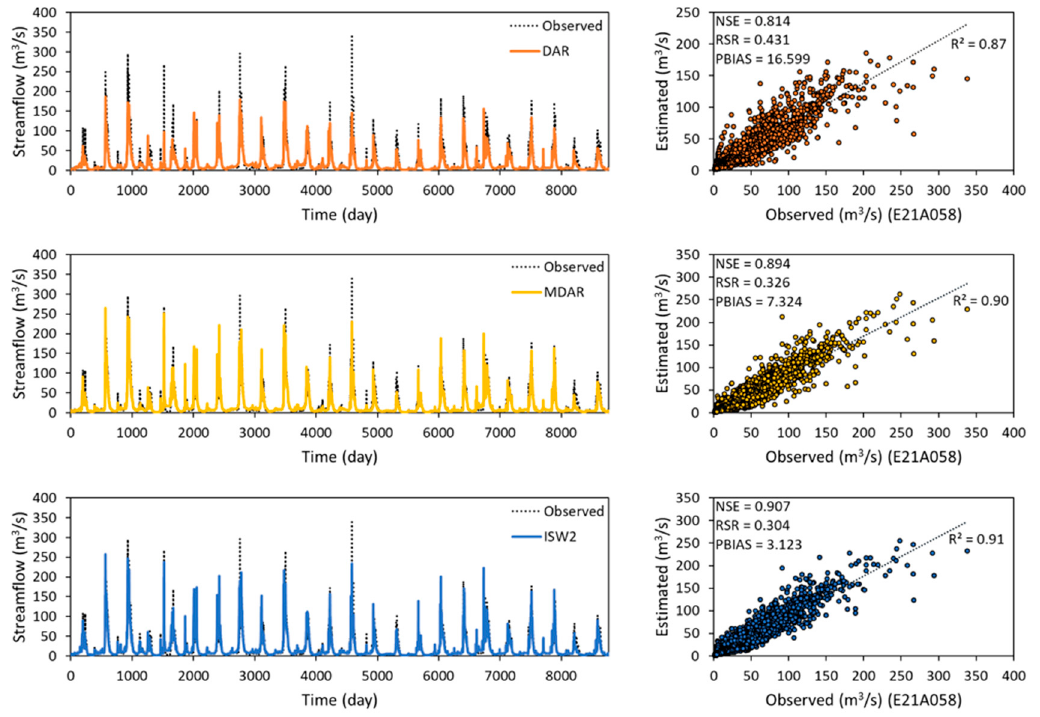
Figure 6. Comparison of daily streamflow estimated using DAR (top row), MDAR (mid row), and ISW2 (bottom row) with observed (original) daily streamflow at station E21A058 in the Middle Euphrates Basin.